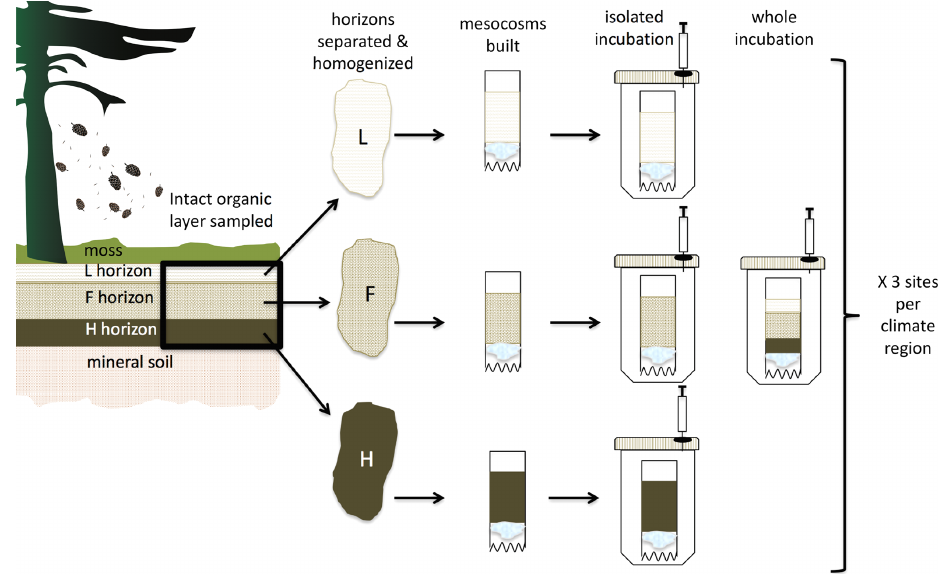
Figure 2. Conceptual figure depicting the experimental design. Organic horizon soils were collected as an intact 20 × 20cm layer from each of the three field sites in each climate region and separated into the individual L , F , and H (equivalent to the Oi, Oe, and Oa in US soil classification) horizons. After homogenization, soil was used as illustrated to set up two sets of incubations. The treatment labeled “isolated” incubated each soil horizon individually and in isolation. The treatment labeled “whole” incubated the L , F , and H horizons together as a whole profile layered as they are in situ and with the mass of each horizon reflecting the average proportional masses of each within the profiles observed across all the